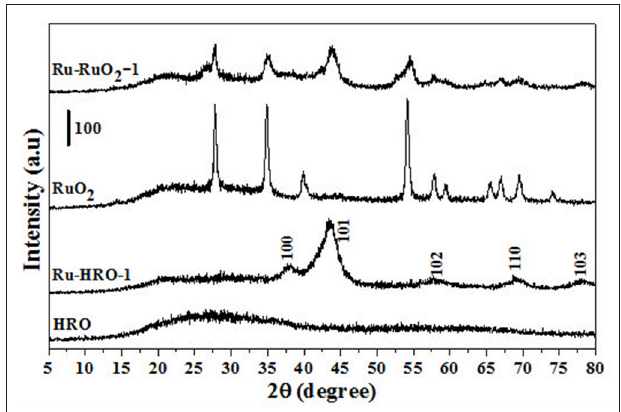
FIGURE 1 | PXRD of materials before (HRO and RuO 2 ) and after reaction (Ru-HRO-1: Recovered material from Table 1 , entry 10 and Ru-RuO 2 -1: Recovered material from Table 1 , entry 11).